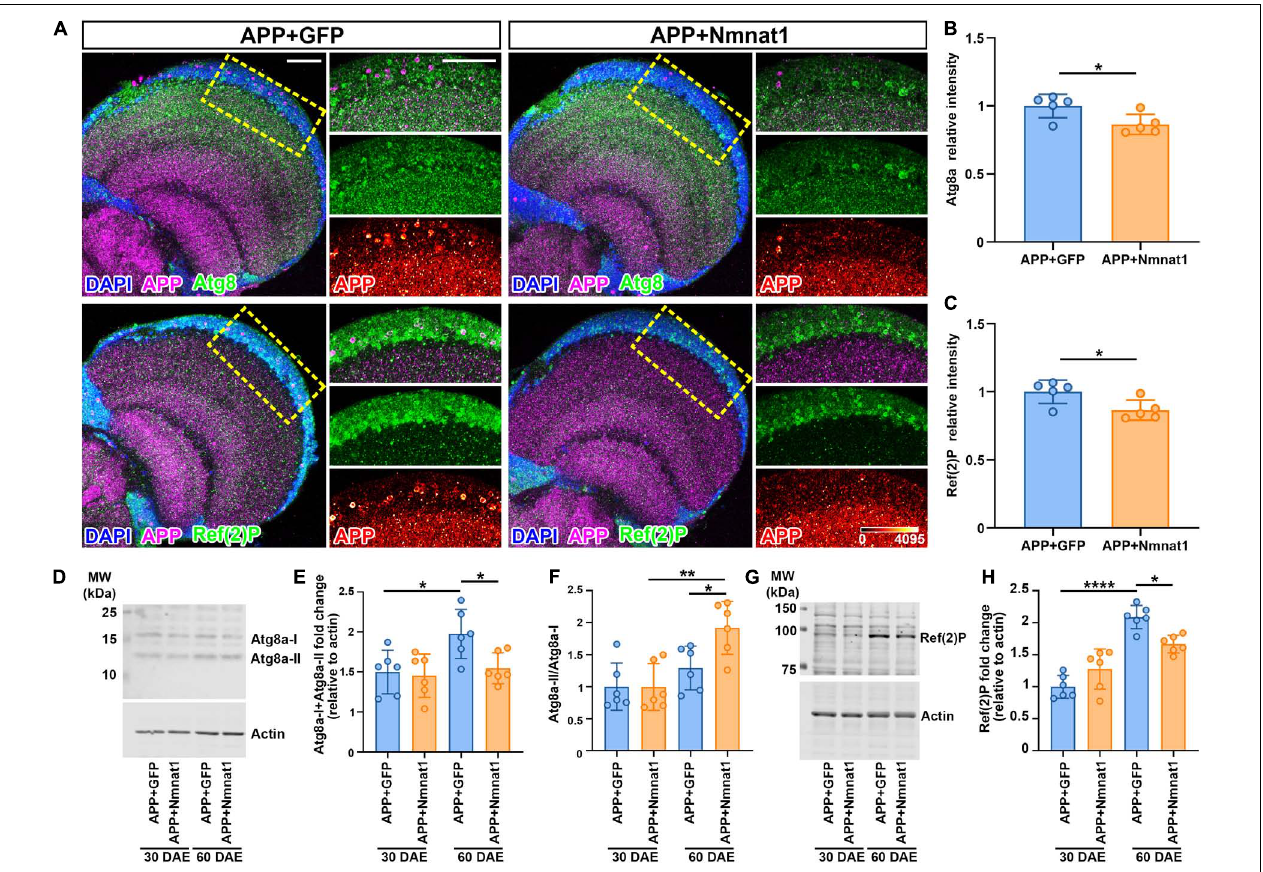
FIGURE 4 | hNmnat1 promotes amyloid aggregates clearance through autophagy. (A) Fly brains at 60 DAE were stained with DAPI (blue), APP (magenta), and Atg8 or Ref(2)P (green). Images in the right column are high magnification of the boxed areas (APP is shown in heatmap). Scale bars = 30 µ m. (B,C) Quantification of relative Atg8a and Ref(2)P intensity shown in panel (A) . Data are expressed as mean ± SD. n = 5/group. Independent sample t -test. * P < 0.05. (D) Western blot analysis showing levels of endogenous Atg8a-I and Atg8a-II in fly brains at 30 and 60 DAE. Actin is used as an internal control. (E,F) Quantification of total Atg8a level (Atg8a-I + Atg8a-II) (E) and the ratio of Atg8a-II to Atg8a-I (F) . Data are expressed as mean ± SD. n = 6/group. One-way ANOVA with Bonferroni’s post hoc test. * P < 0.05, ** P < 0.01. (G) Western blot analysis showing levels of endogenous Ref(2)P in fly brains at 30 and 60 DAE. Actin is used as an internal control. (H) Quantification of Ref(2)P level. Data are expressed as mean ± SD. n = 6/group. One-way ANOVA with Bonferroni’s post hoc test. * P < 0.05, **** P <